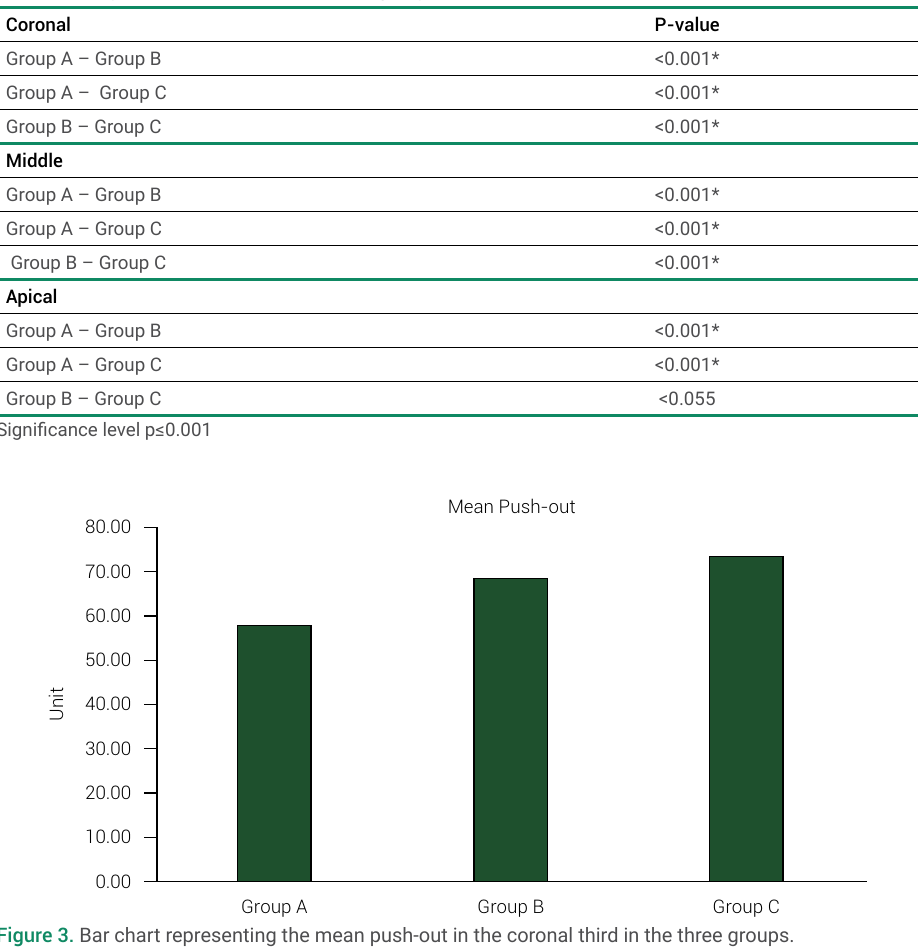
Table 3. Results of Bonferroni post hoc test for pair-wise comparison of push-out (MPa) in the coronal, middle and apical thirds between the three groups: